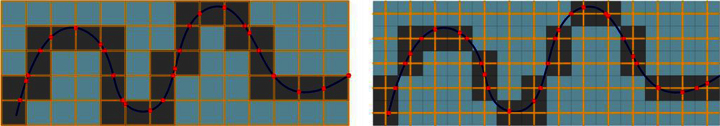
Topological pixilation after [1] the rasterization at the left is based on an ‘outline’ intersection target which ensures a 4-connected rasterized curve in which every pixel has at least one neighbour sharing an edge with; the rasterization at the right is based on a ‘crosshair’ intersection target which ensures an 8-connected rasterized curve in which every pixel has at least one neighbour sharing a vertex with. Resulting pixels are highlighted in dark grey. Intersection Taregts are highlighted in yellow and intersections with them in red dots. Pixels are shown as blue squares.